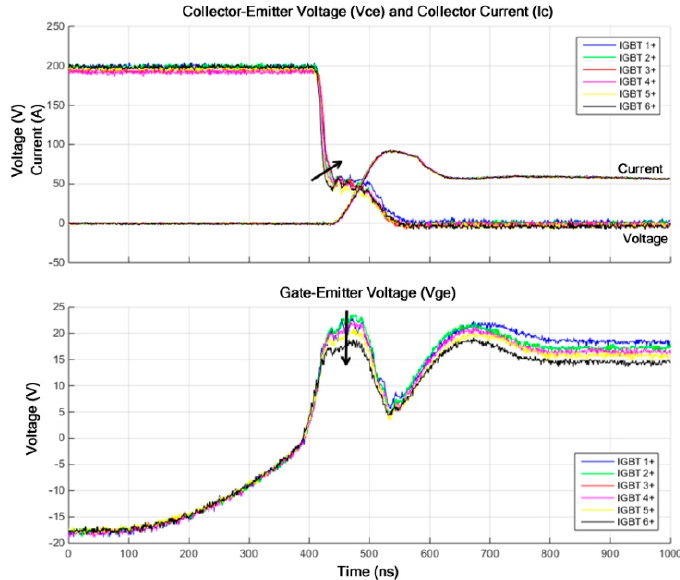
Figure 13. Turn-on switching under snubberless condition. The Vce and Vge voltages of the six series connected IGBTs are shown, as well as the collector current (Ic), showing the effects of the natural intrinsic balancing through gate-emitter voltage.